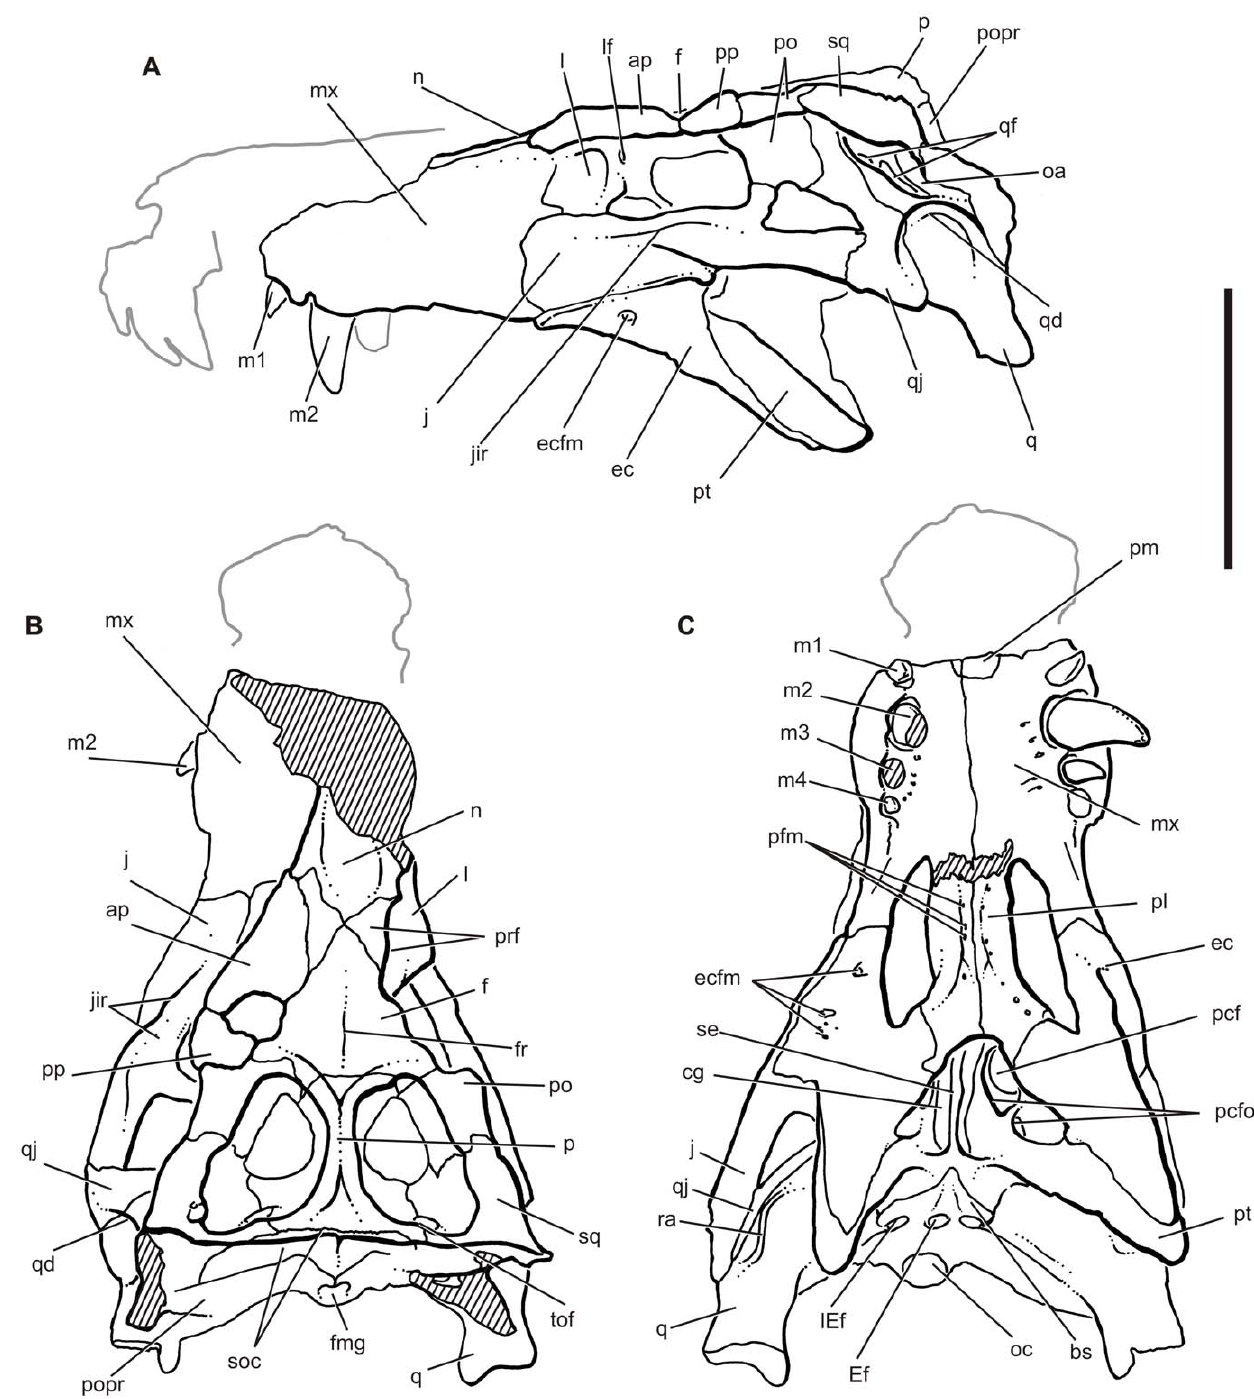
Figure 4. Skull of the baurusuchid Pissarrachampsasera . A) and C) Drawing of the skull LPRP/USP 0019 (holotype) in strict lateral (left) and ventral views, respectively. B) Reconstruction of the dorsal surface of the same skull, based on a strict dorsal view of skull roof and a slightly posterodorsal view of the occipital plane. Hatched areas indicate broken surfaces. Reconstruction of the anterior part of the rostrum based on the referred specimen (LPRP/USP 0018). Abbreviations: ap, anterior palpebral; bs, basisphenoid; cg, choanal groove; ec, ectopterygoid; ecfm, ectopterygoid foramina; Ef, medial Eustachian foramen; f, frontal; fmg, foramen magnum; fr, frontal ridge; j, jugal; jir, jugal infraorbital ridge; l, lacrimal; lEf, lateral Eustachian foramen; lf, lacrimal duct foramen; mx, maxilla; m1-m4, maxillary teeth (1–4); n, nasal; oa, otic aperture; oc, occipital condyle; p, parietal; pcf, parachoanal fenestra; pcfo, parachoanal fossae; pfm, palatine foramina; pfp, pl, palatine; pm, premaxilla; po, postorbital; popr, paraoccipital process; pp, posterior palpebral; prf, prefrontal; pt, pterygoid; q, quadrate; qd, quadrate depression; qf, quadrate fenestrae; qj, quadratojugal; ra, ridge ‘A’; se, choanal septum; soc, supraoccipital; sq, squamosal; tof, temporo-orbital foramen. Scale bar equals 10 cm.